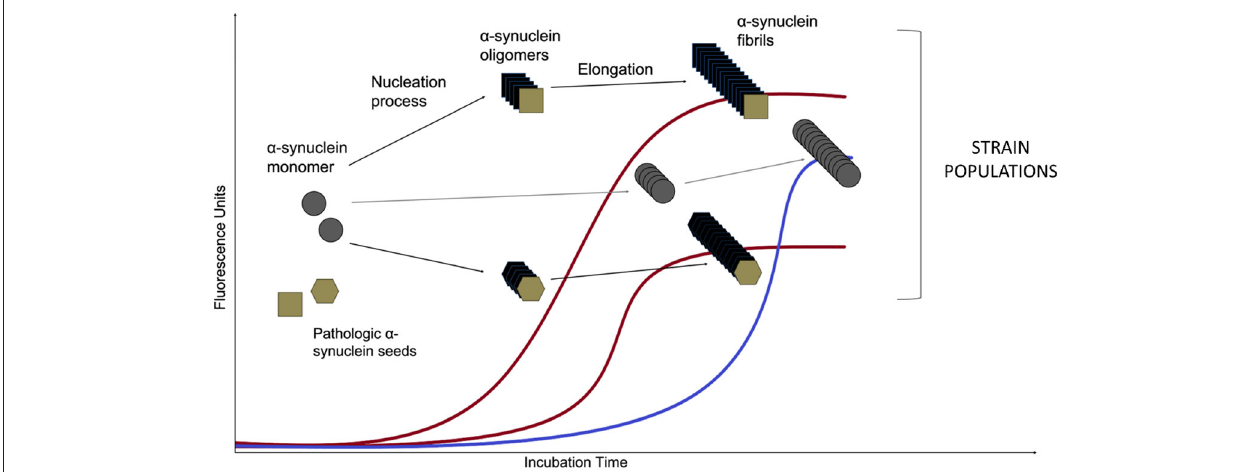
FIGURE 3 | Asyn aggregation in a SAA reaction. Monomeric recombinant asyn substrate is added to the wells of a multi-well plate, along with the amyloid-selective fluorescent dye Thioflavin T and the biospecimen to be tested for the presence of asyn seeds. After an initial lag phase, the monomeric asyn can form de novo aggregates (so-called oligomers) that further elongate to form amyloid type β -sheet-rich fibrils during the exponential phase (the de novo pathway is marked in blue). The presence of structurally different asyn seeds, e.g., from PD and MSA patients (Shahnawaz et al., 2020) lead to structurally different asyn conformers, called strains, that can be detected in real time due to the ability of dyes (such as Thioflavin T and K114) that emit fluorescence when bound to amyloid structures. Distinct strains present different conformations and subsequently, altered affinity for binding of the fluorescent molecules. That leads to variations of maximum fluorescent values. The de novo aggregation kinetics are usually characterized by an extended lag phase when compared to the seeded aggregation and this difference forms the basis for diagnosing a biospecimen positive or negative for the presence of asyn